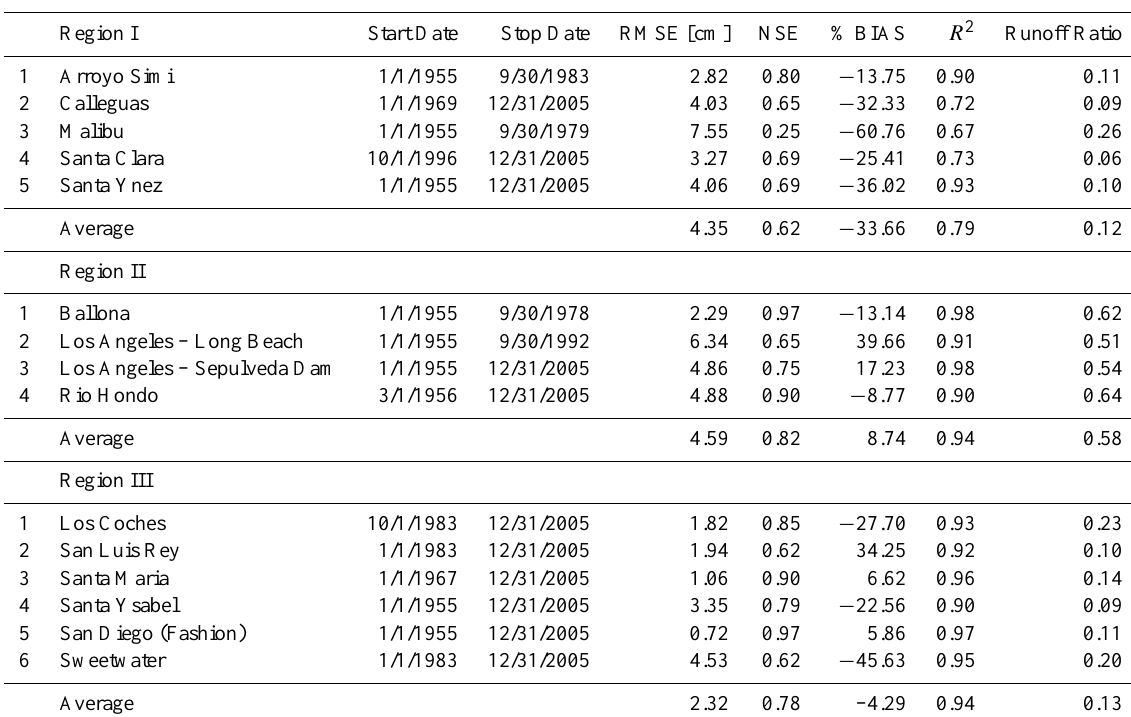
Table 5. Hydrologic statistics comparing mean monthly flow depth of observations and archetypal outputs for the same observed period. Runoff ratios are calculated using total annual precipitation and flow depth for each